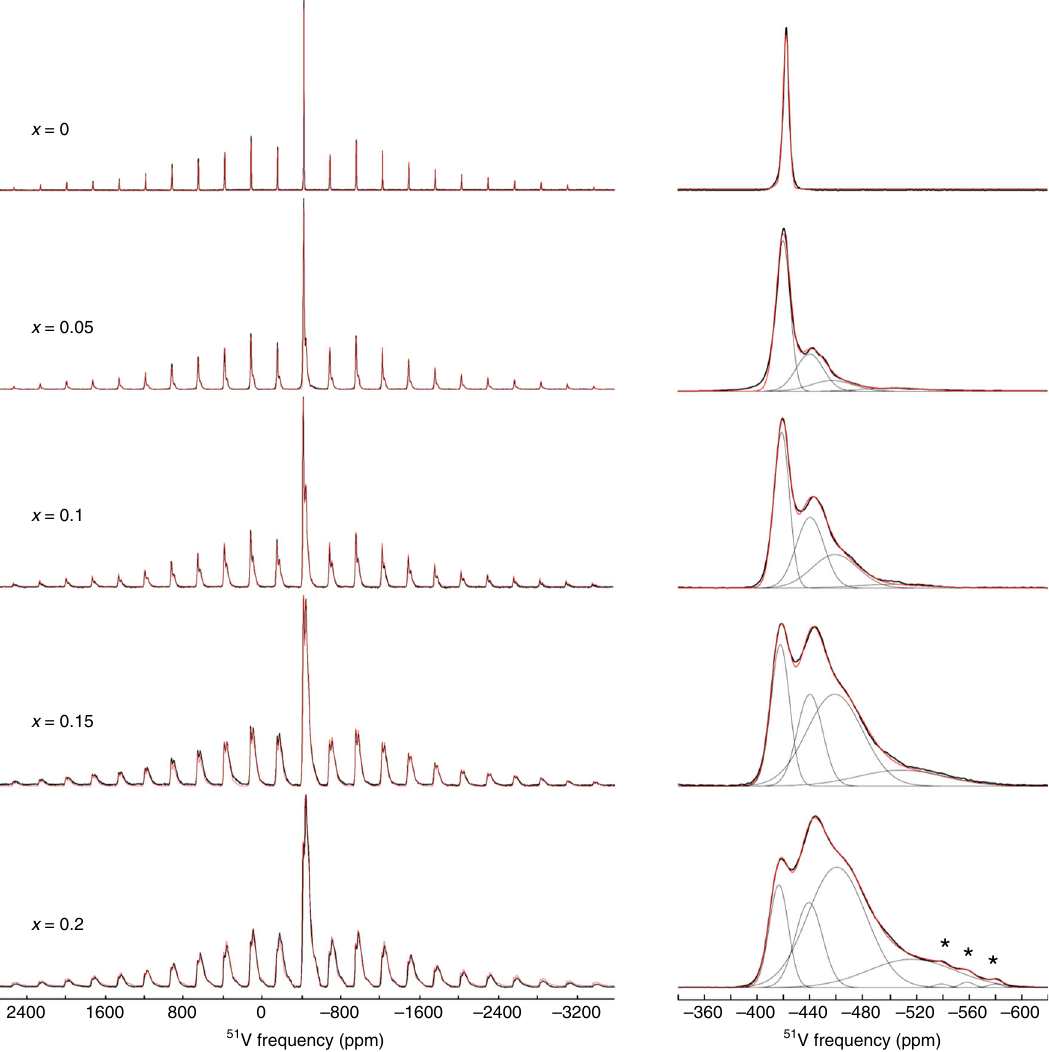
Fig. 3 51 V MAS NMR spectra of Bi 1 − x Sr x VO 4 − 0.5 x . (Left) Quantitative 51 V MAS spectra recorded at 20.0 T with a spinning frequency of 60 kHz (black) and their corresponding best fi ts (red). (Right) expansion of the central-transition region. The four distinct contributions are shown as thin black lines and asterisks mark impurities (probably BiSr 2 V 3 O 11